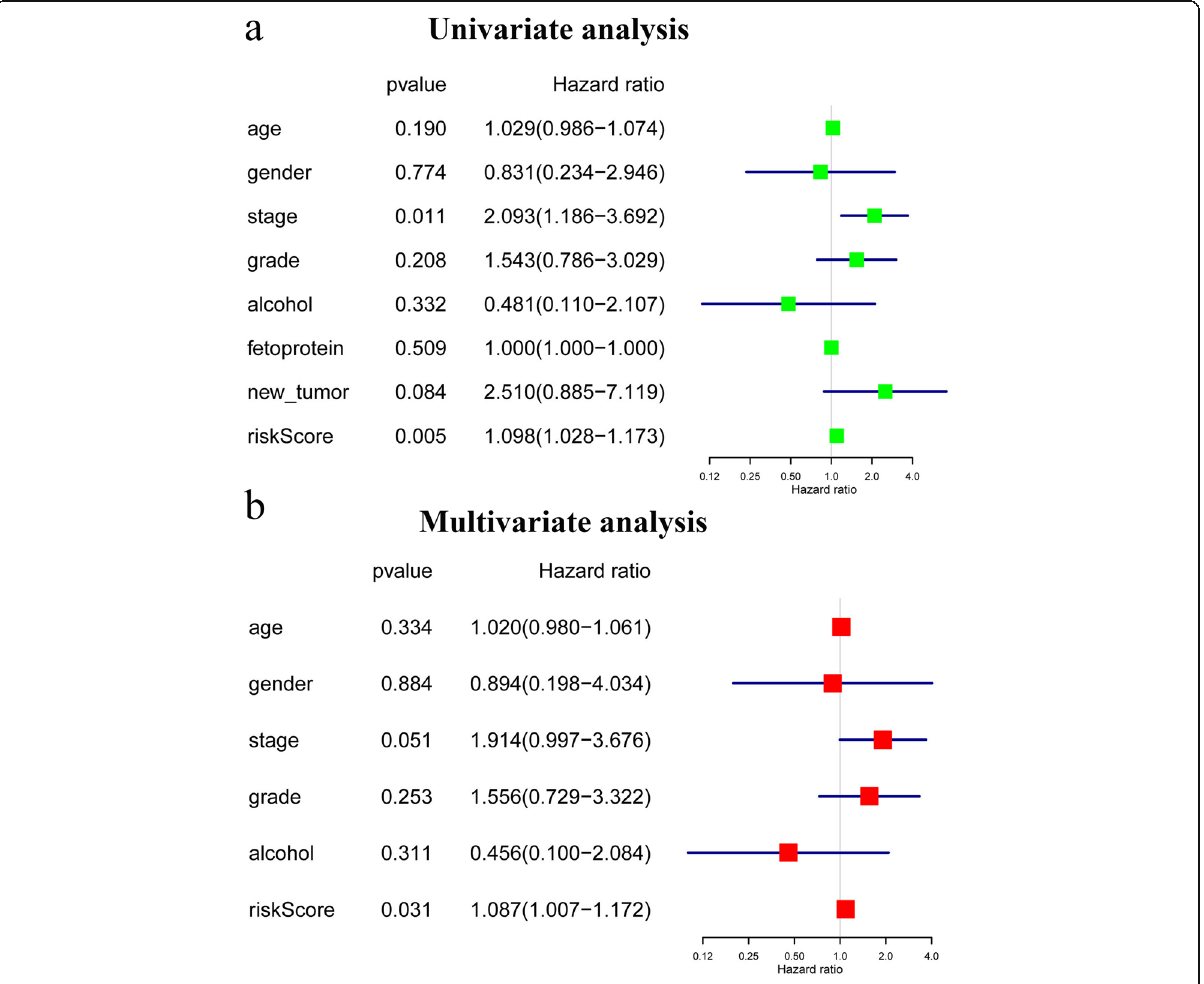
Fig. 4 Forest plot of the univariate and multivariate Cox regression analysis in HBV-related HCC. a Univariate regression analysis in HBV-related HCC. b Multivariate Cox regression analysis in HBV-related